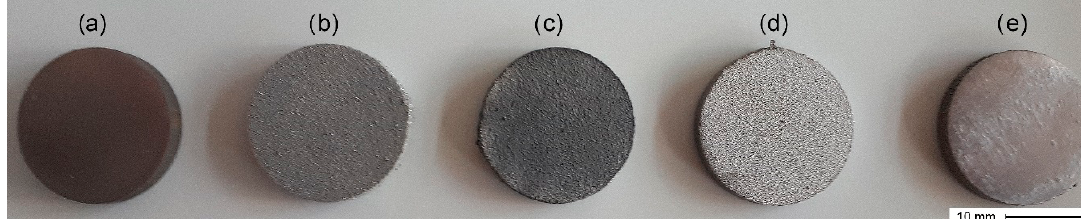
Figure 1. Images of the alloy specimens after different surface treatments ( a ) Solid bar; ( b ) Untreated selective laser melting (SLM); ( c ) Sandblasted SLM; ( d ) Etched SLM; and, ( e ) Ground SLM.